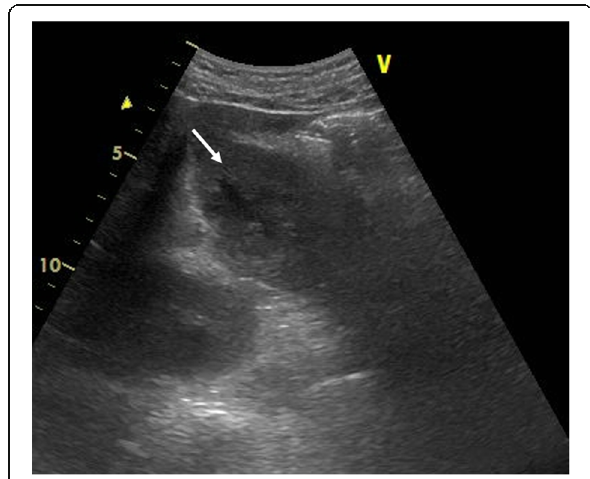
Fig. 1 Abdominal ultrasonography findings. A hypoechoic lesion with an irregular margin (white arrow) was located in the left lobe of the liver